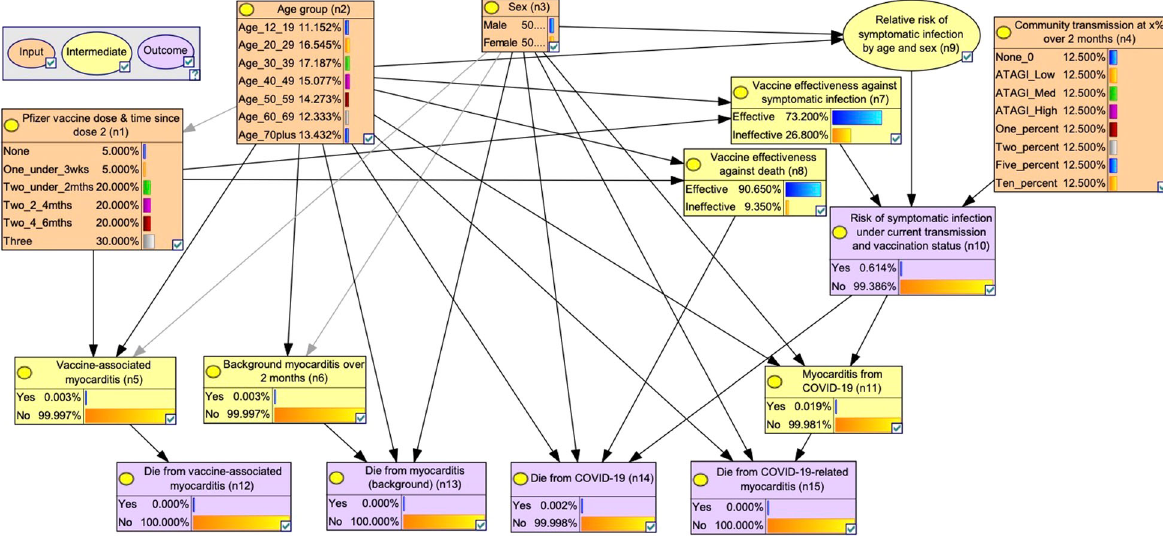
Fig. 1 Bayesian network for assessing risks versus bene fi ts of the P fi zer COVID-19 vaccine in Australia. Input nodes in orange (n1 – n4), intermediate nodes in yellow (n5 – 9, n11), and outcome nodes in purple (n10, n12 – 15). All nodes are shown in their default